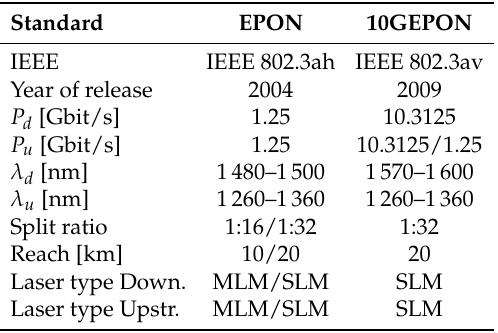
Table 2. Parameters of the Institute of Electrical and Electronics Engineers (IEEE) PONs.